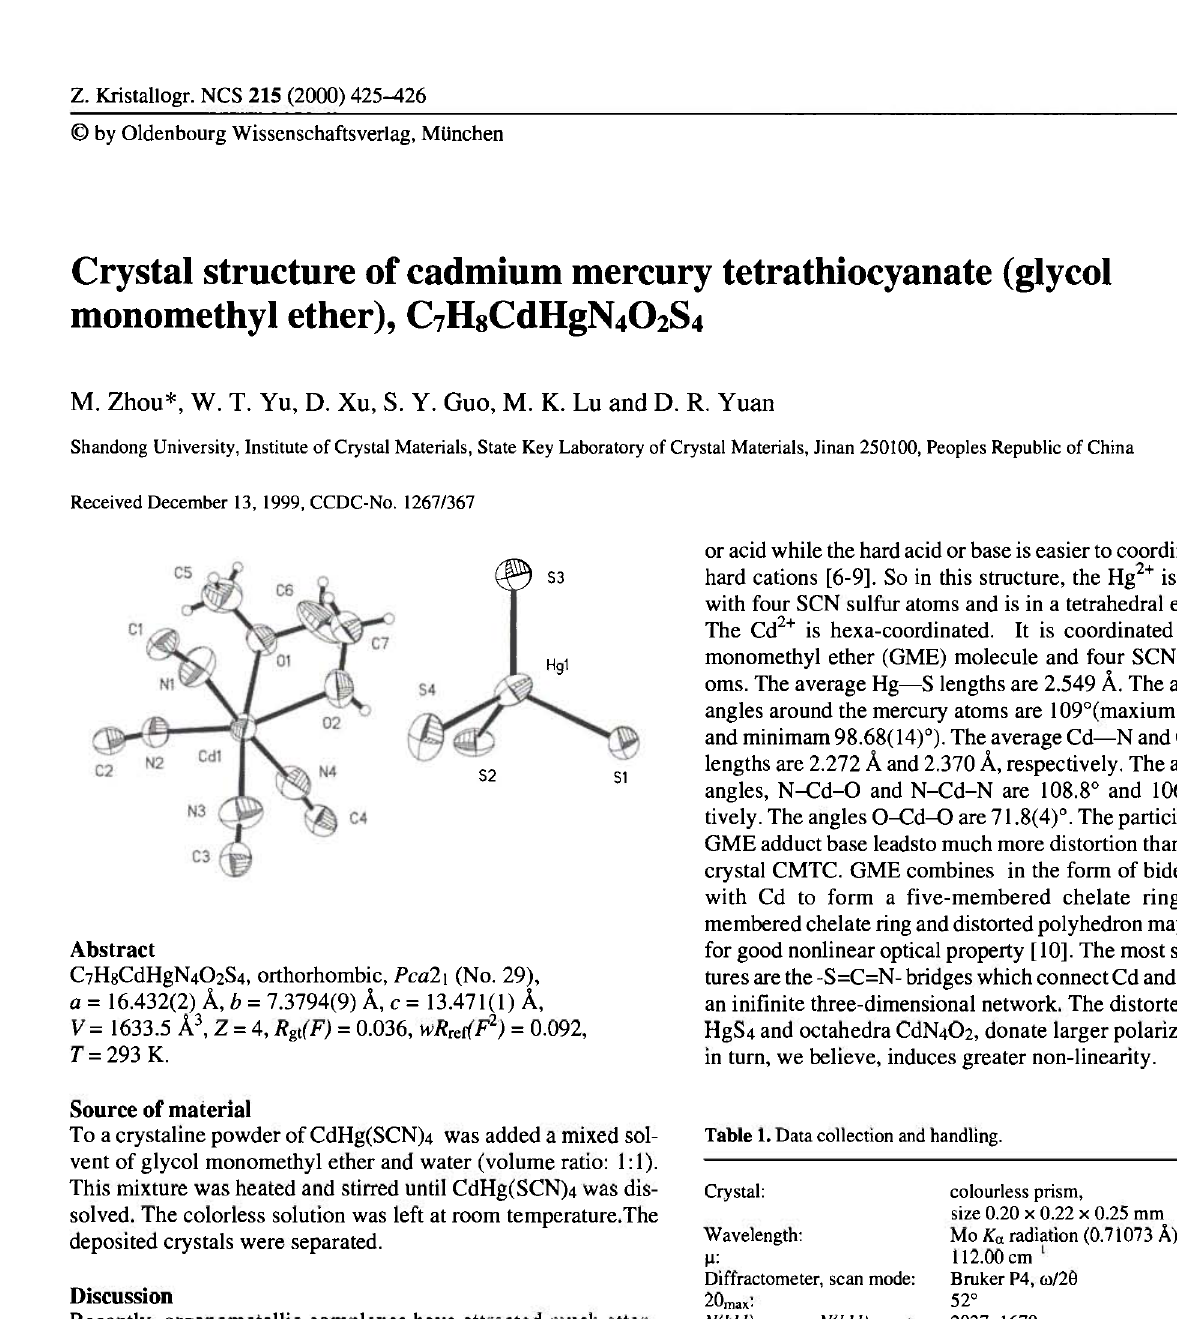
Table 2. Atomic coordinates and displacement parameters (in Ä 2